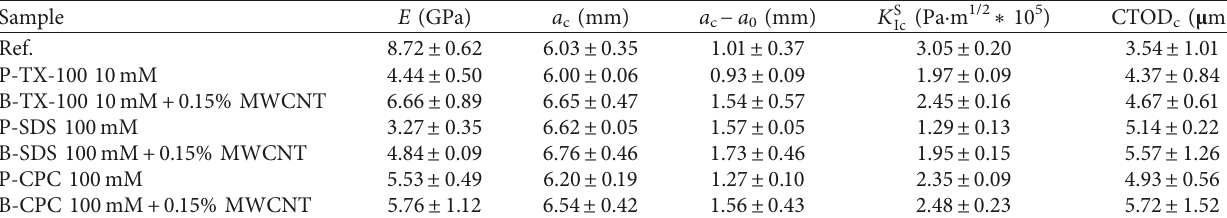
Table 3: Fracture mechanics analysis results.